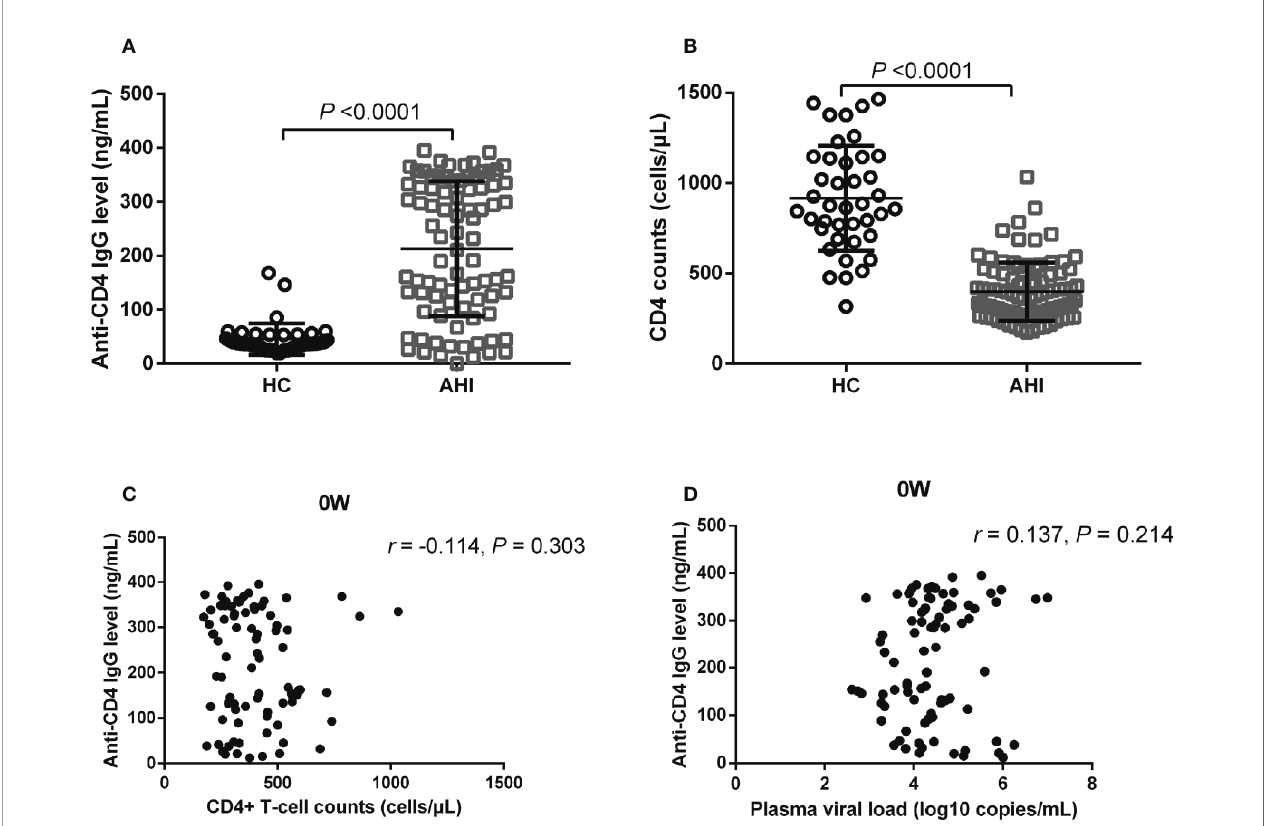
FIGURE 1 | Plasma Anti-CD4 IgG Levels and CD4 + T-cell Counts in HCs and ART-naive AHI Individuals. Plasma anti-CD4 IgG levels (A) and CD4 + T-cell counts (B) in healthy controls (n = 40) and AHI individuals (n = 90) prior to ART. Correlations between plasma anti-CD4 IgG levels and peripheral CD4 + T-cell counts (C) and plasma HIV RNA levels (D) in AHI individuals prior to ART. Non-parametric Mann-Whitney tests and Spearman ’ s rank tests, with P < 0.05 considered signi fi